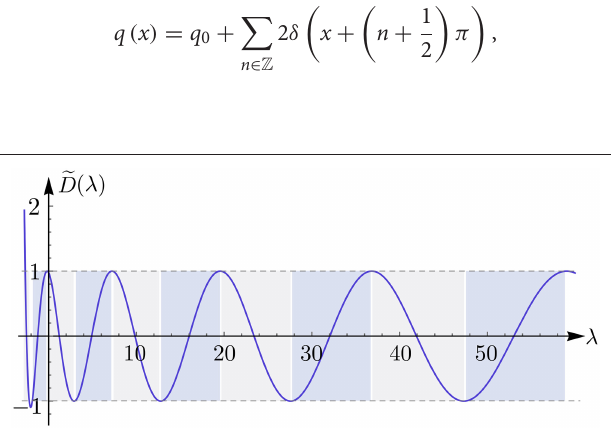
FIGURE 2 | Plot of the approximate function